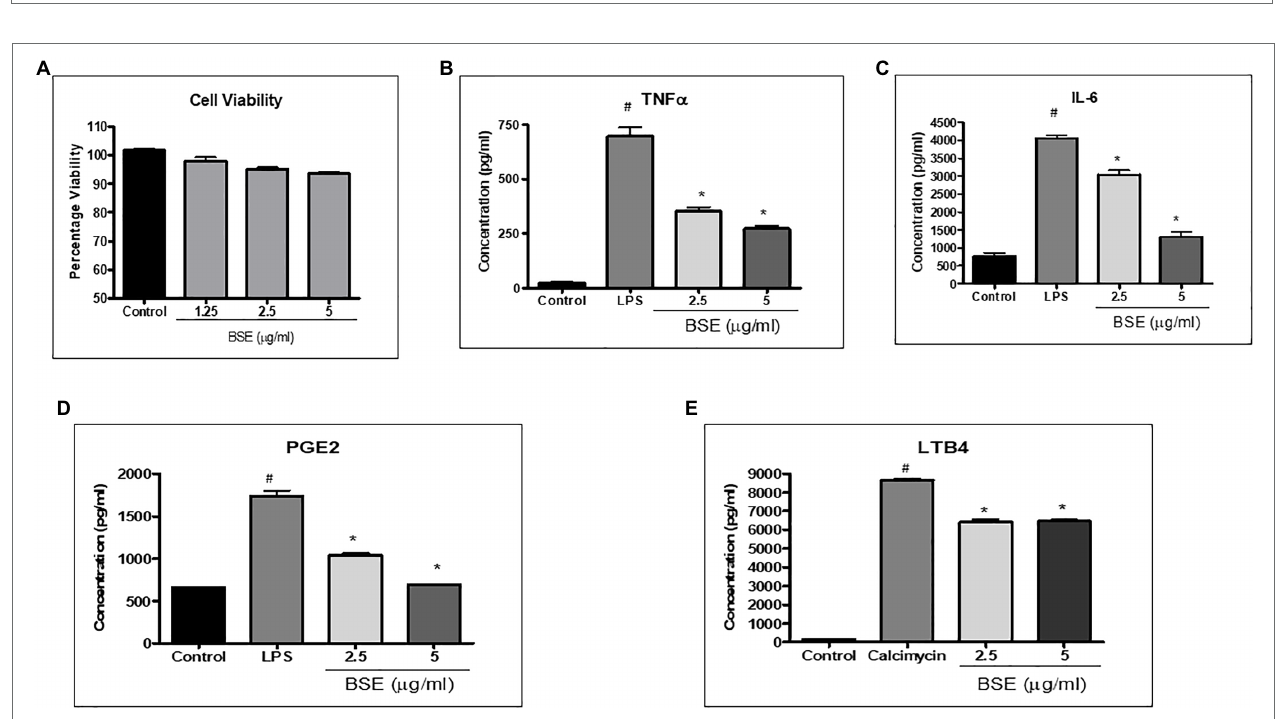
FIGURE 1 | The β -Boswellic acids in BSE were analyzed by HPLC using a C18 column and a mobile phase of acetonitrile and water in the ratio of 90:10 with 0.05 ml of glacial acetic acid. BBA and ABBA are detected at 210 nm (A) and KBBA and AKBBA at 254 nm (B) .